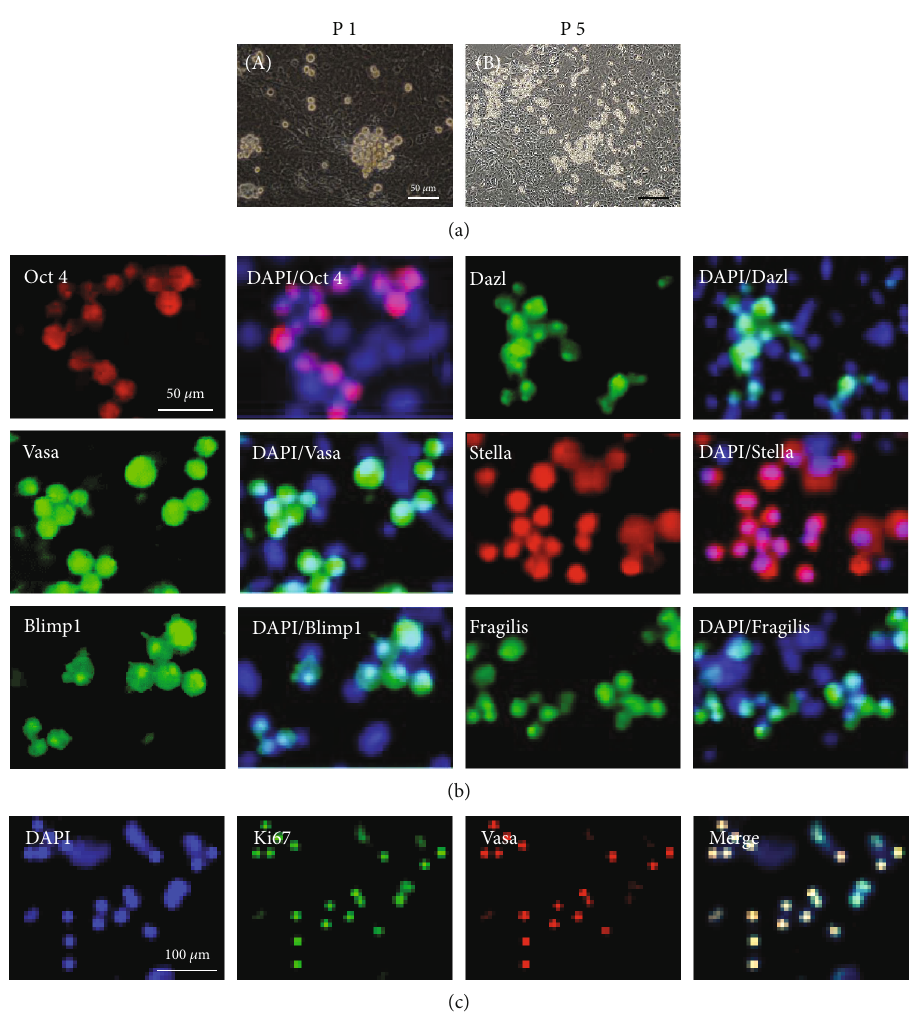
Figure 2: Characterization of established female mouse germline stem cells. (a) Phase contrast microscopy of cultured cells during passaging (day 30 at di ff erent passages (A: after passage 1; B: after passage 5) of fGSCs on MEF-coated plates. (b) Immuno fl uorescence staining for germline markers (Oct4, Vasa, Dazl, Blimp1, Stella, and Fragilis) in fGSCs (after 2 passages) in MEF-coated plates. Cells were counterstained with 4,6-diamidino-2-phenylindole (DAPI, blue) to visualize the nucleus. (c) Assessment of GSC proliferation by dual immuno fl uorescence for Vasa (red) expression and Ki67 incorporation